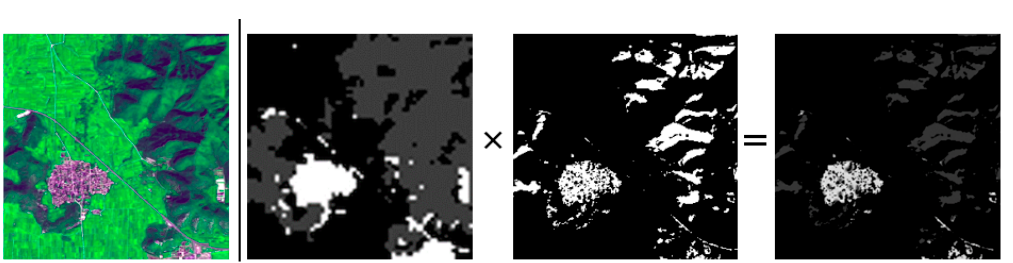
Figure 6. Joint multi-image saliency map generation (from left to right : original image, RGB component, CIELab component, and JMS).